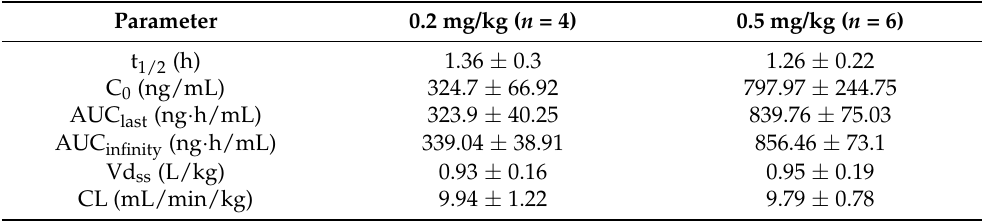
Table 3. Average non-compartmental toxicokinetic parameters of hexamethylenetetramine obtained after iv injection in rats.